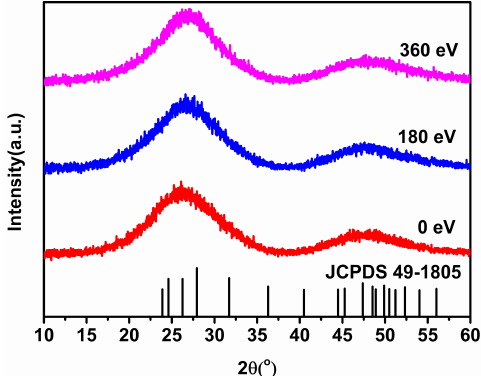
Figure 2. XRD spectra of the YbF 3 films.